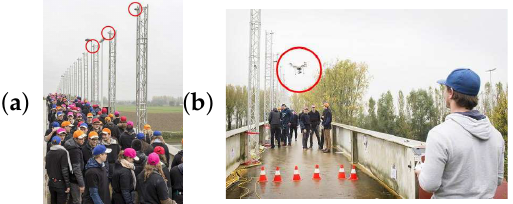
Figure 4. Recording the pedestrians during the measurement campaign: ( a ) static camera setup and ( b ) pilot controlling drone during takeoff. The cameras are indicated with a red